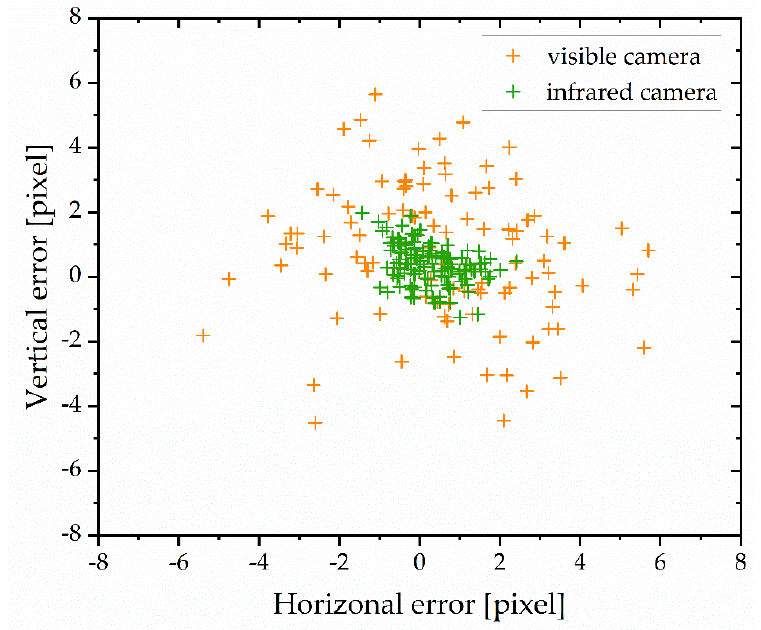
Figure 5. Reprojection errors for the visible and infrared all-sky-view cameras.